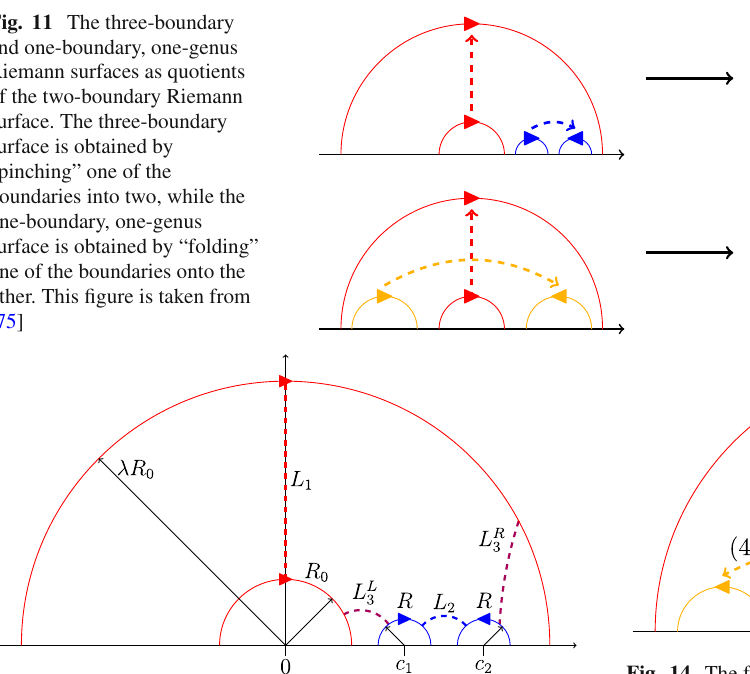
Fig. 12 The fundamental domain of the three-boundary Riemann sur- face. The color-coded dashed lines L 1 , 2 , 3 are the minimal periodic geodesics, whose lengths are the three physical parameters of the system. The variables λ , R 0 , R , c 1 , and c 2 represent parameters for the picture. This figure is taken from [75]